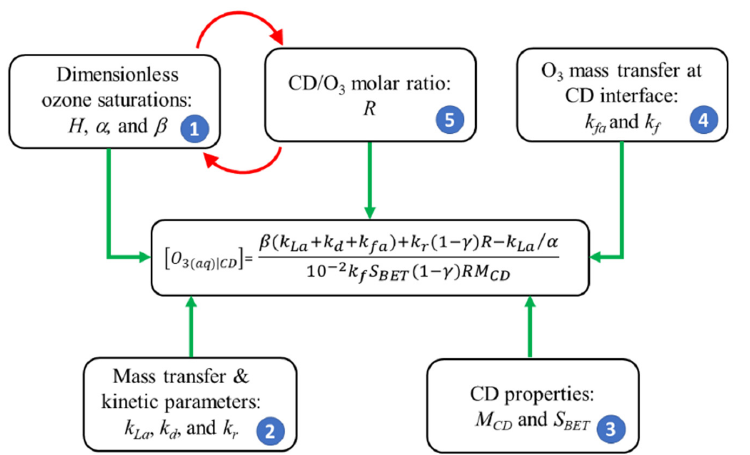
Figure 11. A summary of parameters needed for the prediction of interfacial ozone concentration ( O 3 ( aq ) | CD ) using Equation (11).